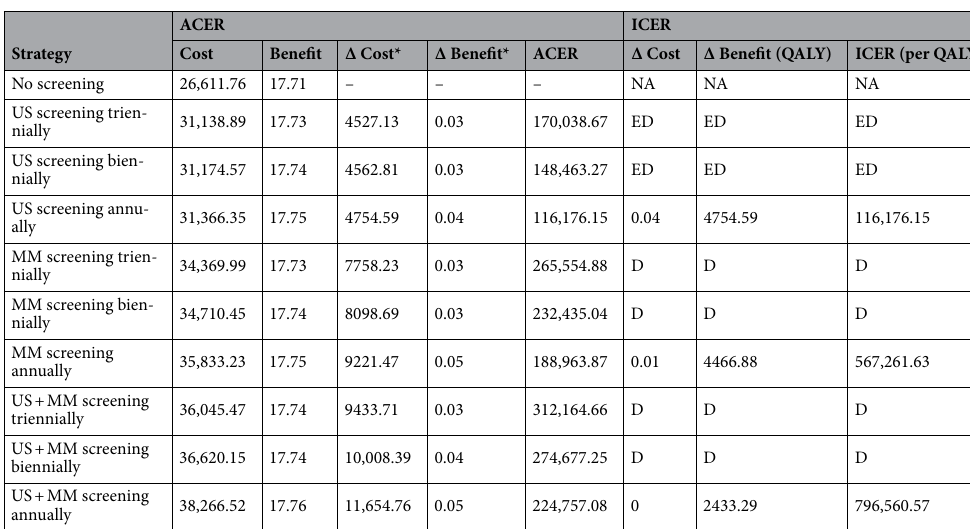
Table 5. The cost-effectiveness ratios of high risk-based breast cancer screening strategies in Urban Hebei Province. Incremental is denoted as ‘Δ’. Benefit and incremental benefit are measured in quality-adjusted life-